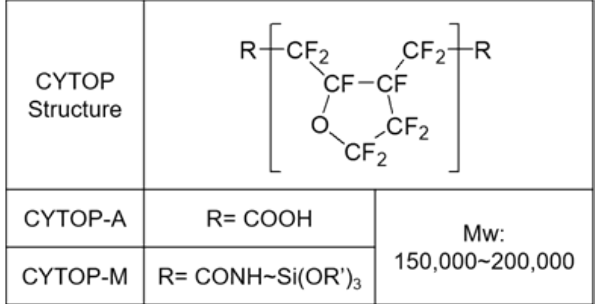
Figure 2. The structure and molecular weight of the CYTOP fluoropolymer. R indicates the terminal functional groups, which (as shown) were carboxyl groups in CYTOP-A (low polar terminal functional group) and amide groups in CYTOP-M (high polar terminal functional group).